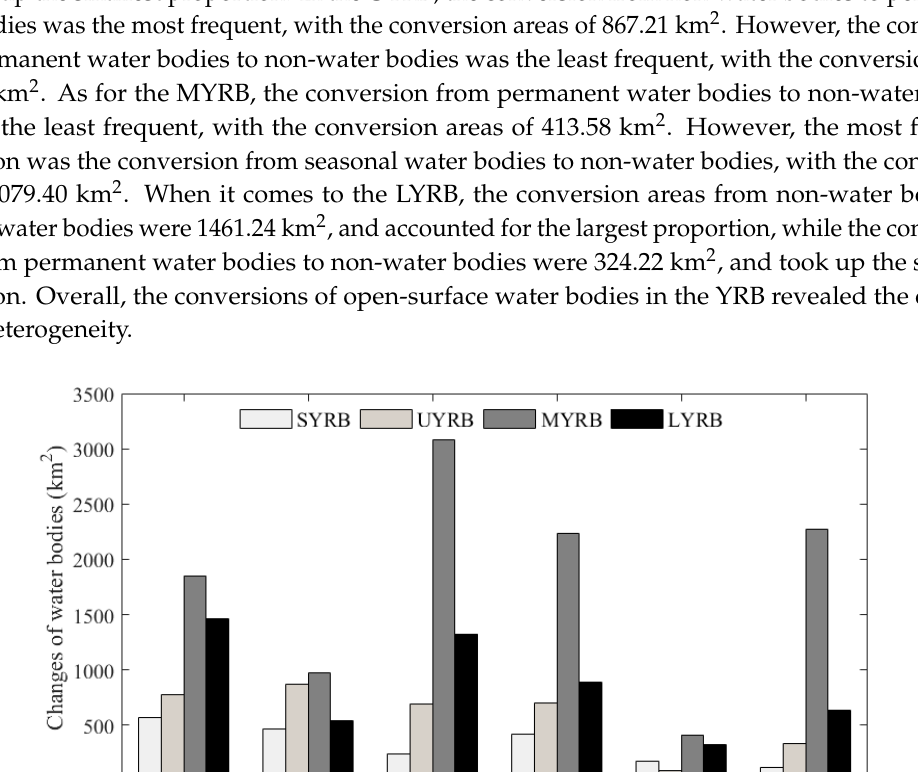
Figure 10. The conversion of surface water bodies from 1984 to 2018 for the sub-basins in the YRB.